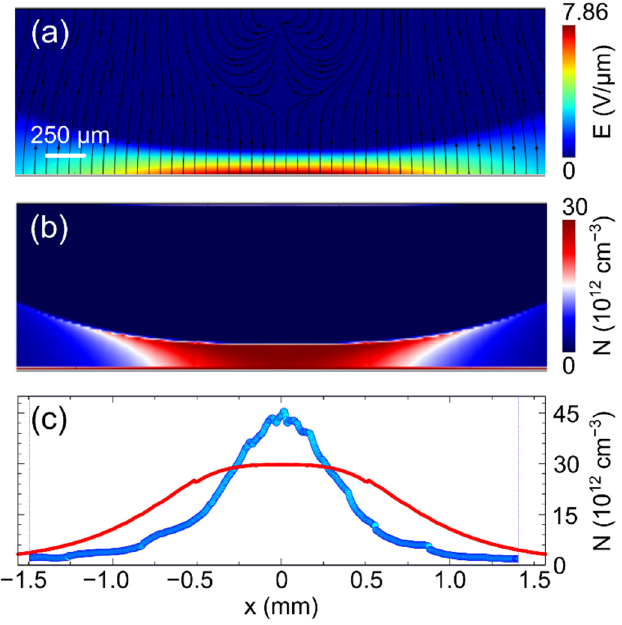
Figure 7. Numerical simulations corresponding to the experimental conditions in Figure 5: ( a ) electric field map with streamlines indicating its local direction, ( b ) space charge map, ( c ) space charge horizontal crosscut (passing by the maximum), red solid line, compared to the experimental horizontal profile, blue dots.